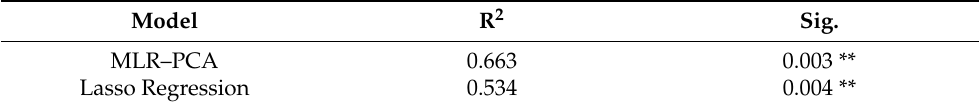
Table 7. Comparison of fitting degree and significance test of different models ( *: p < 0.05 **: p < 0.01 ***: p < 0.001 ).